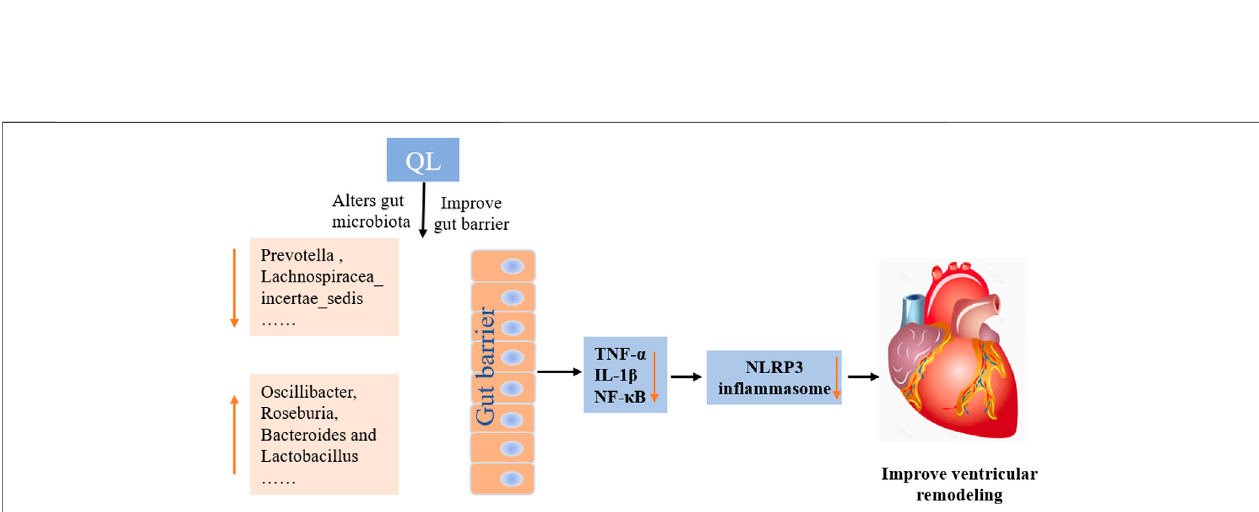
Frontiers in Pharmacology |